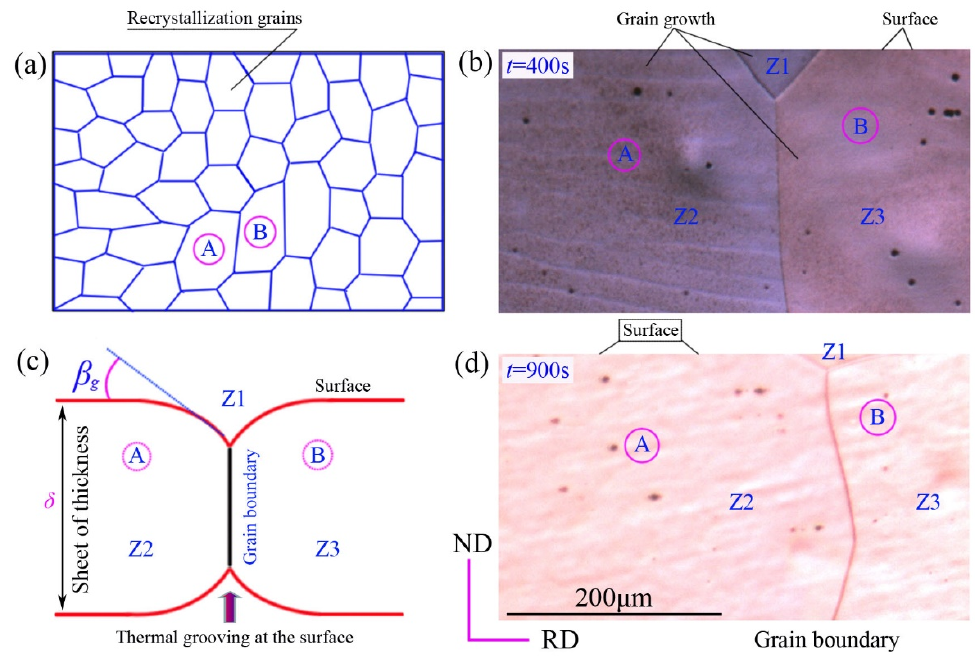
Figure 7. Schematic of thermal grooving of high purity aluminum foils during annealing ( a ) recrys- tallization; ( b , c ) grain growth at t = 400 s and t = 900 s; ( d ) model of thermal grooving at the surface.